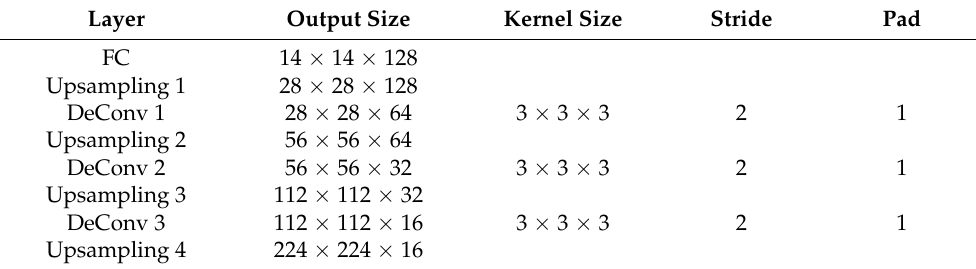
Table 2. I3D-AE; the main parameters of the